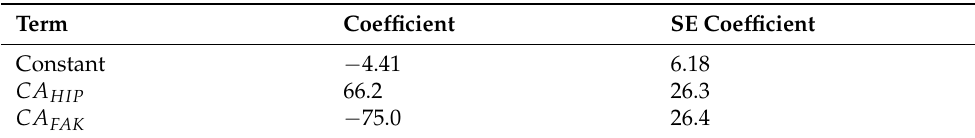
Table 7. The coefficients and standard error of the variables for the best-fit binary logistic regres- sion model.